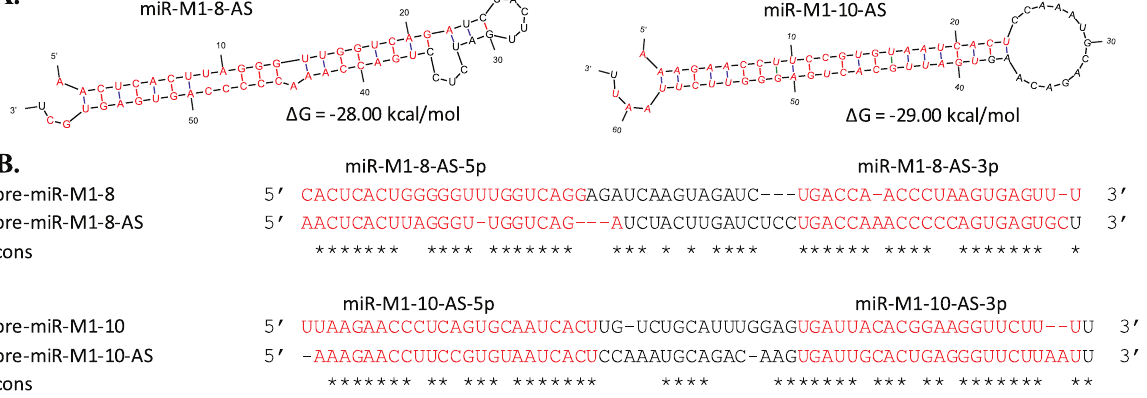
Figure 1. Two novel MHV68 antisense miRNAs. (A) Hairpin structures of miR-M1-8-AS and miR-M1-10-AS with the miRNAs annotated in red on both arms. (B) Sequence similarities between sense and antisense precursors of miR-M1-8-AS and miR-M1-10-AS where the miRNA sequences are annotated in red. The color bar on the last line shows the similarity between this pair of sense and antisense miRNAs.